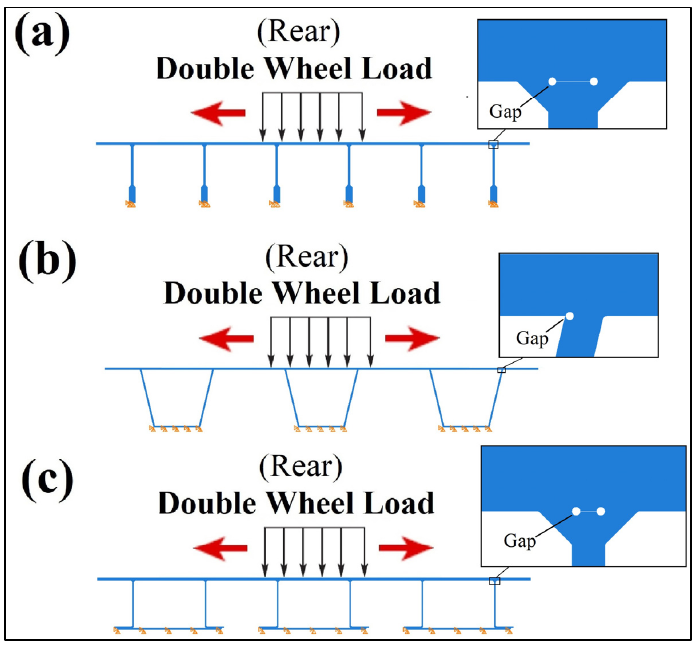
Figure 8. Plane strain assemblies: ( a ) Bulb section; ( b ) Trapezoidal section; ( c ) Built-up section.